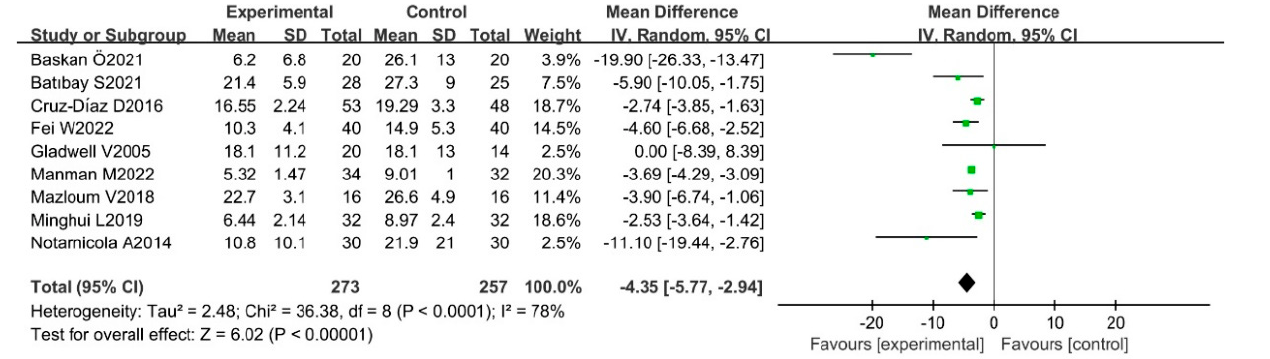
Figure 5. Meta-analysis of the effect of Pilates on ODI in CLBP patients [12,19,20,46,50–53,55].